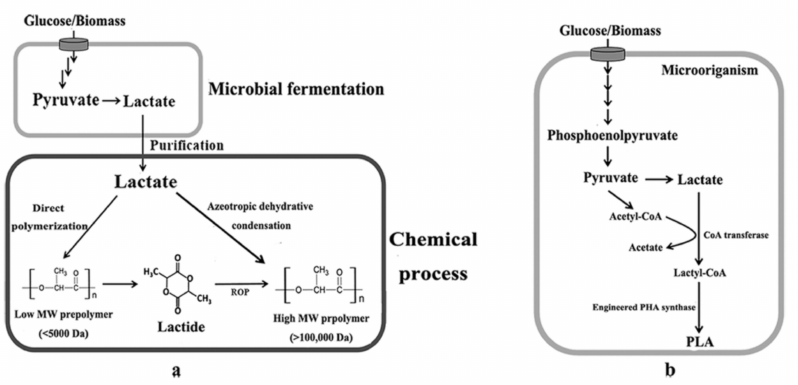
Figure 2. The process of PLA synthesis. ( a ) bio-chemical hybrid process; ( b ) one-step fermentative production by metabolically engineered